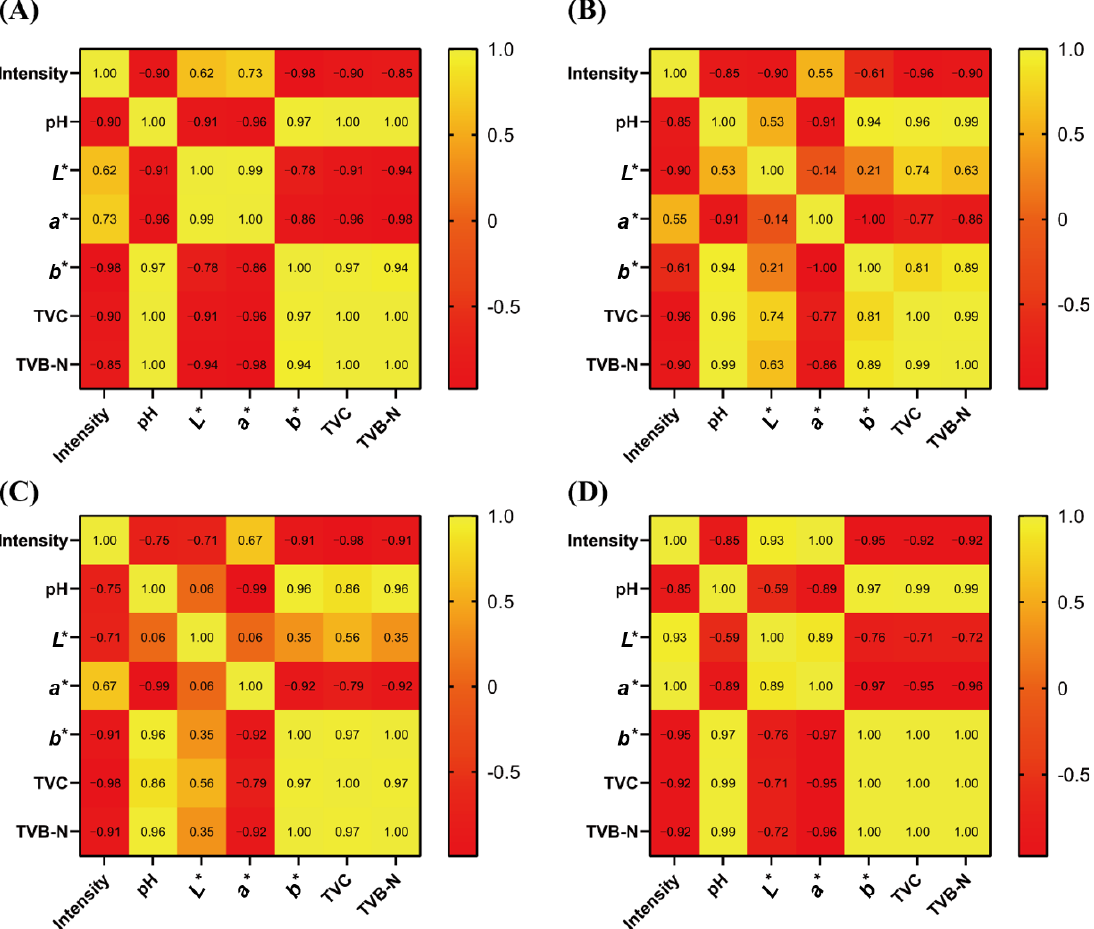
Figure 4. Pearson correlation between intensity of peptide MVHMASKE and basic freshness indi- cators in pork under storage at − 2 °C ( A ), 4 °C ( B ), 10 °C ( C ), and 25 °C ( D